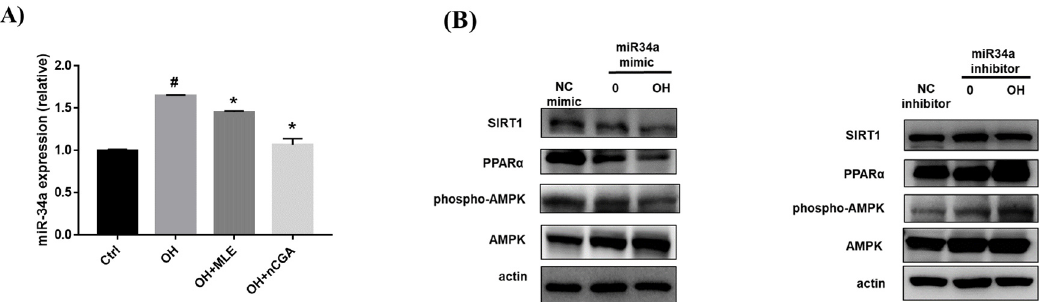
Figure 6. MLE and nCGA reduced miR-34a expression in OH − induced HepG2 cells. ( A ) HepG2 cells were co-treated with OH, MLE (3 mg/mL), and nCGA (50 µ M) at 37 ◦ C for 24 h. The level of miR-34a was analyzed using Real-Time PCR. ( B ) Transfection with miR-34a mimics or inhibitors in the HepG2 cells were measured by Western blotting to detect SIRT1, PPAR- α , and p-AMPK/AMPK. Values are the mean ± SD of three independent experiments. Data were represented using the Student’s t -test. # p < 0.05 vs. control group. * p < 0.05 vs. the OH group.